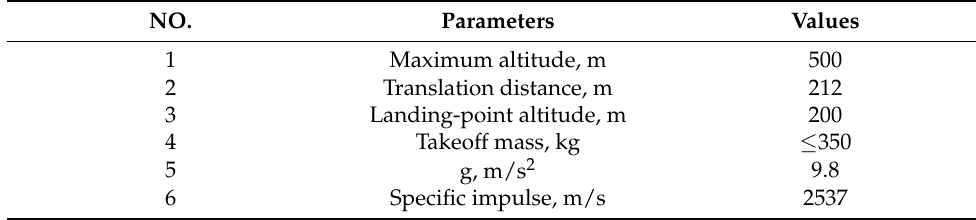
Table 2. Design input for the second scenario.